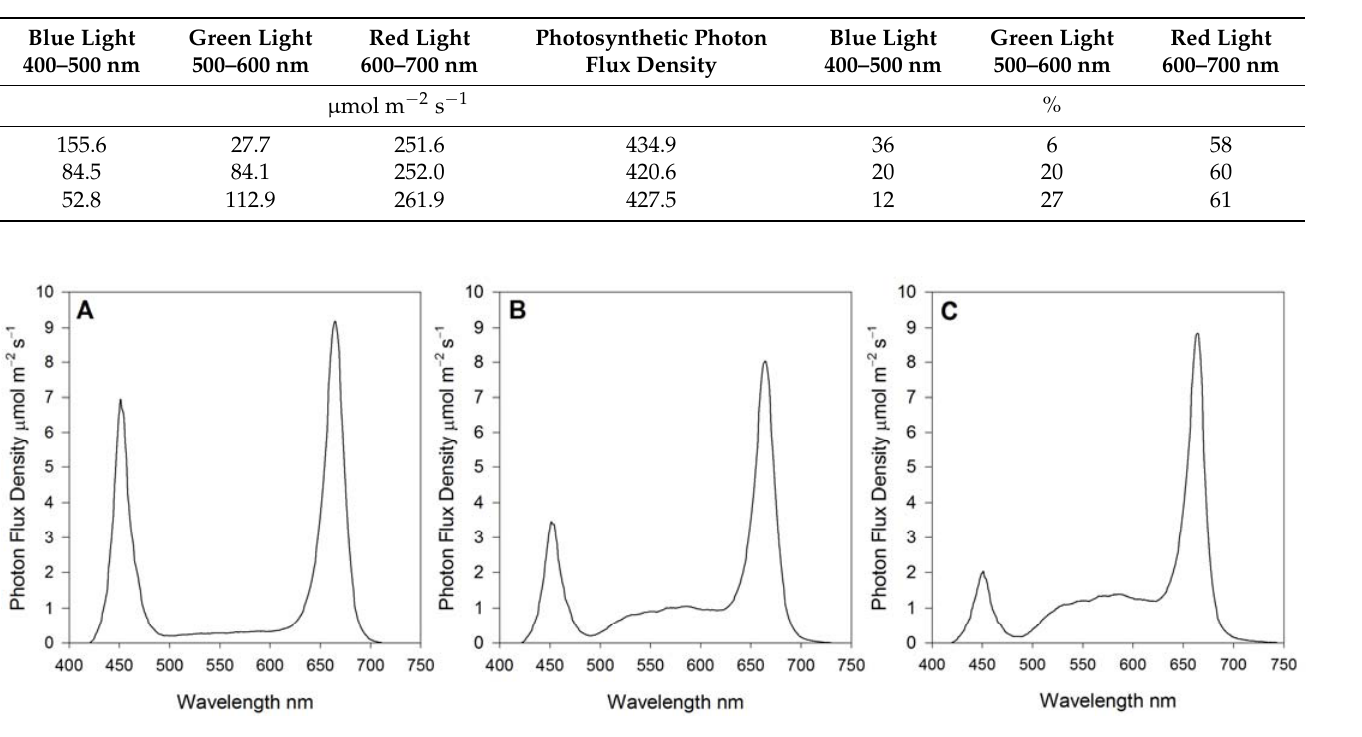
Figure 2. Spectral distribution of light of three LED lamps recorded with a spectroradiometer at 20 cm of distance. ( A ) = 36% blue, 6% green, 58% red light. ( B ) = 20% blue, 20% green, 60% red light. ( C ) = 12% blue, 27% green, 61% red light.